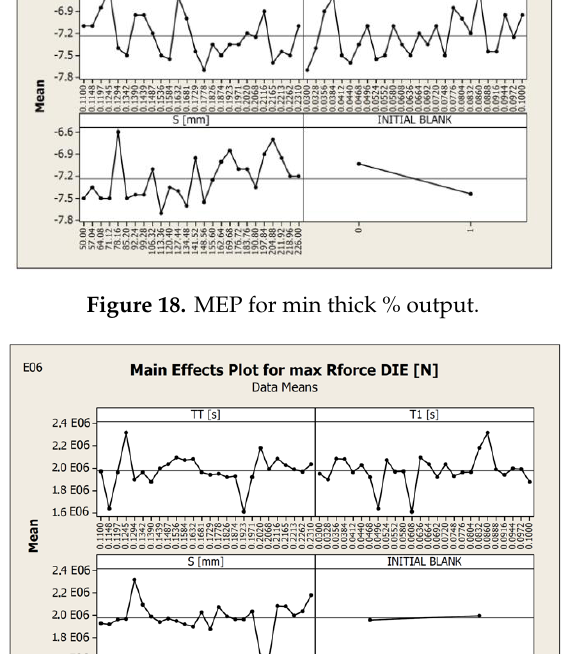
Figure 19. MEP for reaction force output.